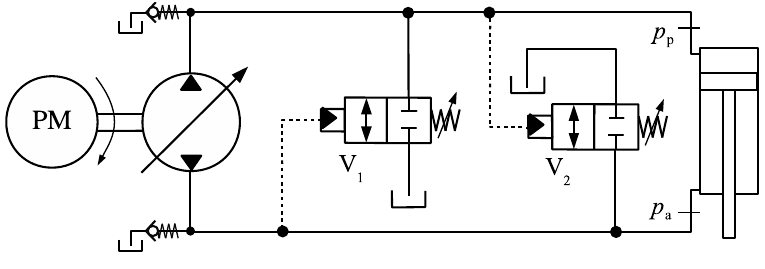
Figure 4. Alternative circuit using two 2 × 2 valves.